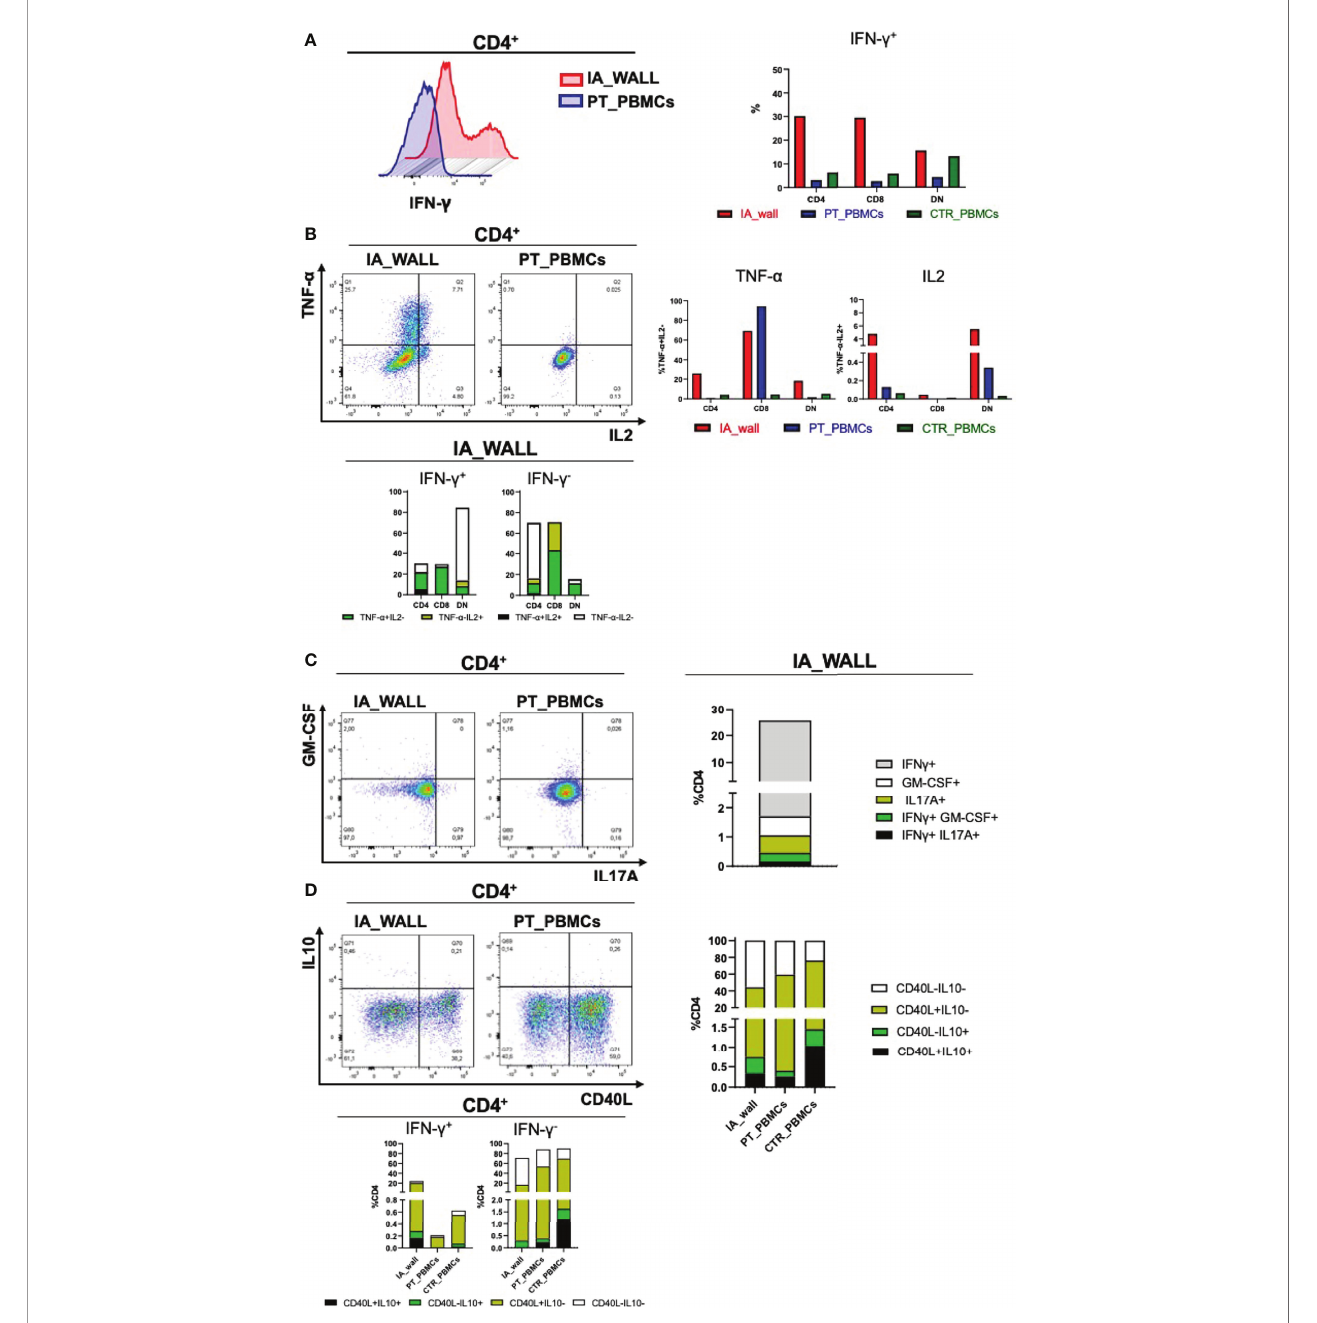
FIGURE 6 | Poly-functional T-cell subsets in the IA wall produce mainly IFN- g , TNF- a and IL-2 (A) . Left histogram overlay shows IFN- g production by CD4+T-cells in the IA wall and in the blood of the patient. Right panel: Frequencies of IFN- g producing CD4+, CD8+ and DN T-cells in the IA wall (red) and in peripheral blood of the patient (blue) and of the pediatric control (green). (B) Analysis of TNF- a and IL2 production (upper left dot plots and upper right bar histograms). Co-expression of TNF- a , IL2 and IFN- g in CD4+, CD8+ and DN subsets in the IA wall is shown in the lower panel. Frequencies were calculated on total CD4+, CD8+ and DN cells. TNF- a and IL2 co-expressing cells among IFN- g + (right) and IFN- g - (left) cells are in black, cells that produce neither TNF- a nor IL2 in white, and cells that express only TNF- a or IL2 are colored. (C) Co-expression of GM-CSF, IL17A and IFN- g among CD4+T-cells. Left dot plots show intracellular GM-CSF versus IL17A production in the IA wall and in the blood of the patient. Co-expression with IFN- g of the two cytokine (IL17 in black and GM-CSF in green) is shown in the right stacked histogram in the IA wall. (D) CD40L expression versus IL10 production in CD4+T-cells are show in the left dot plots for CD4+T-cells and in the right stacked histograms in the upper panels for all T-cell subsets. Expression of IL10 and CD40L, alone (coloured as indicated) or in combination (black), in IFN- g + and in IFN- g - cells for all samples is shown in the stacked histograms of the lower